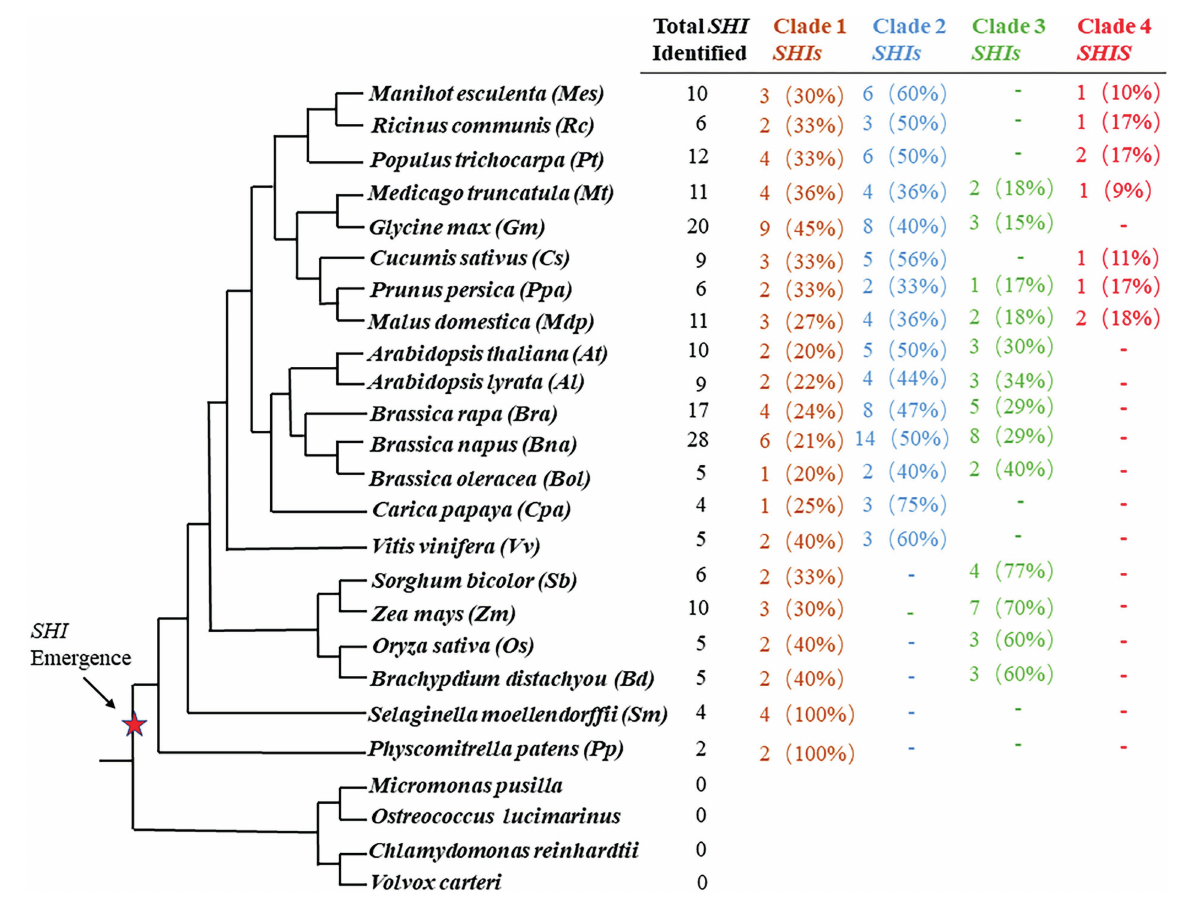
FIGURE 1 SHI/STY genes are identified in land plants. The number of SHI/STY genes identified in each sequenced plant genome was listed in sequence. Percentages for each type are listed in parentheses. The red star marks indicate when SHI/STY appeared during the evolution of land plants. “-” indicates that there is no SHI/STY in this